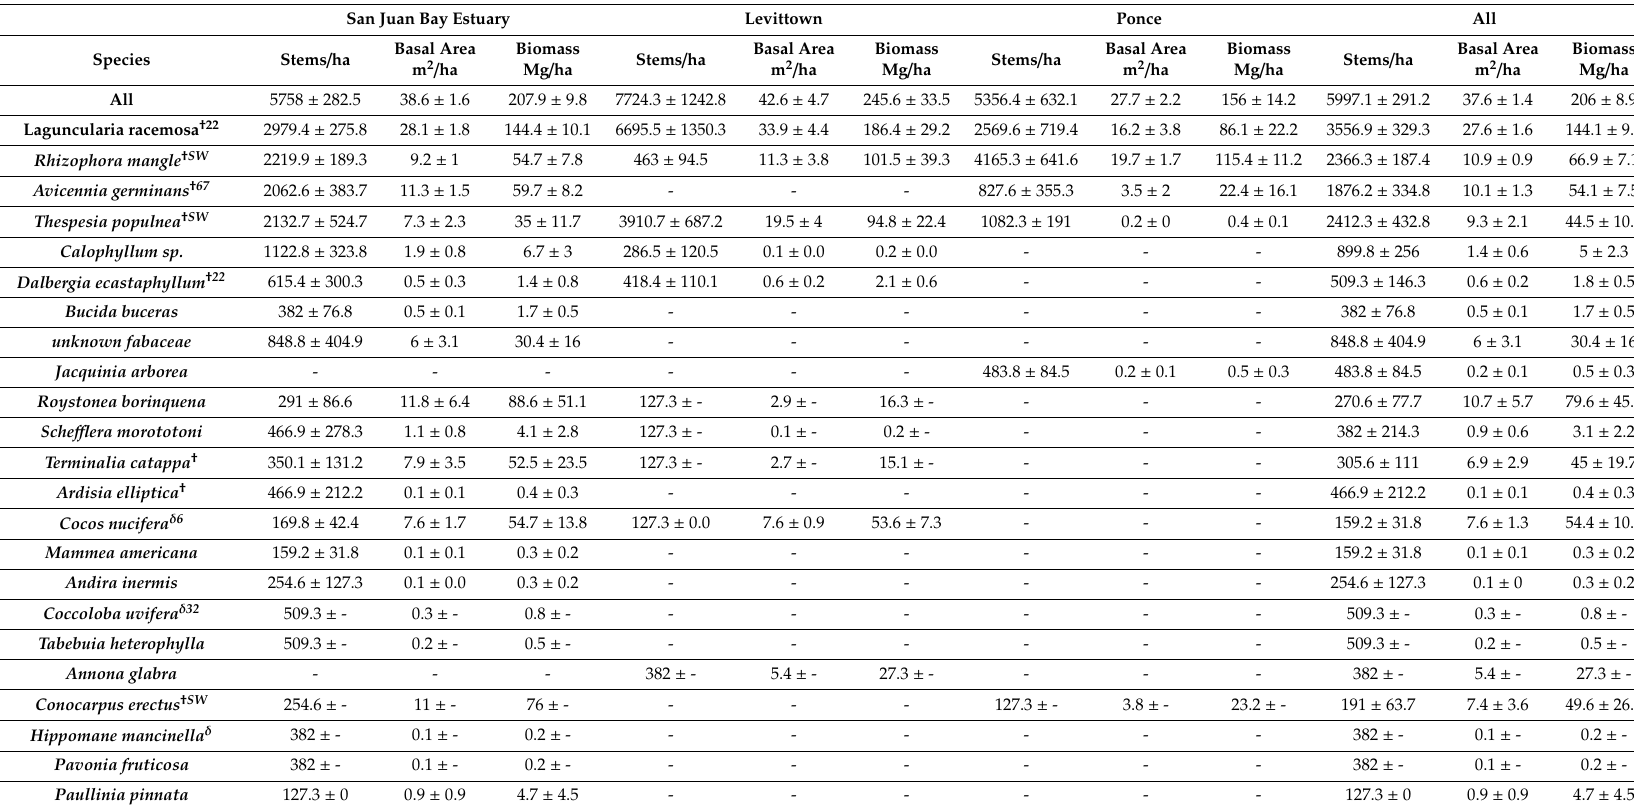
Table 4. Average and standard error of stem, basal area, and biomass per hectare of all species within the three watersheds included in the study, ordered by average stem density across sites. One individual each of seven additional non-identified species were found in one plot of one site in the San Juan Bay Estuary. Halophytic plant types and salinity tolerances (ppt) provided as superscripts and obtained from Santos et al. [50], when